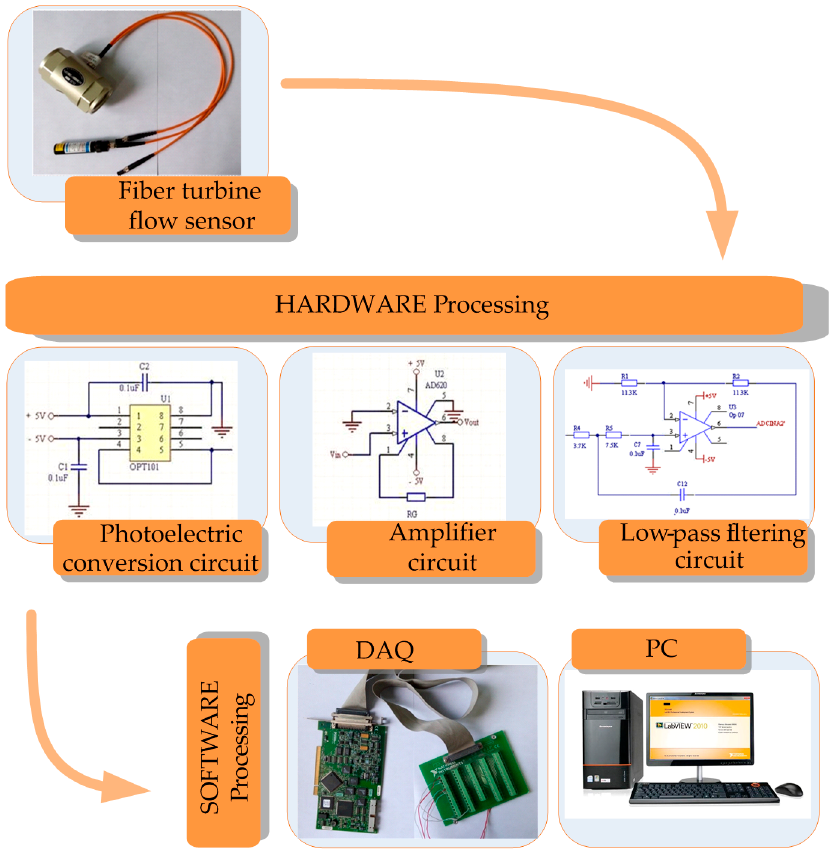
Figure 6. The fiber turbine flow measurement system.